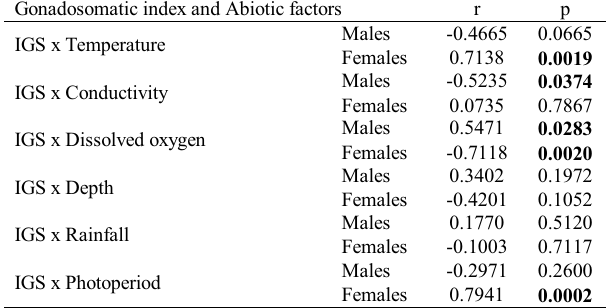
Table 1. Correlations based upon Spearman’s rank test be- tween mean gonadosomatic index (IGS) of Gymnotus aff. carapo and somatic factors in lagoa Verde, Itapuã State Park. Gonadosomatic index and somatic factors